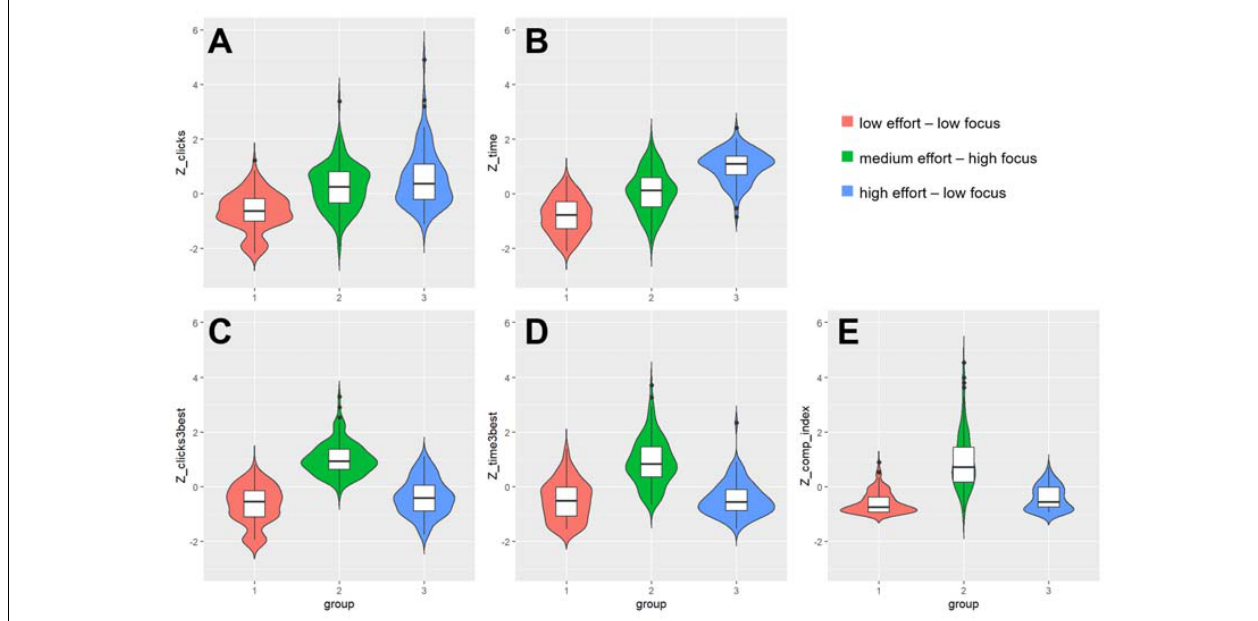
FIGURE 2 | Box and violin plots of the five behavioral measures of information processing behavior as a function of cluster assignment regarding (A) number of clicks; (B) total time; (C) clicks on 3 best; (D) time on 3 best; and (E) comparison index. Note: Boxes depict interquartile range with median in the center; density curves depict the distribution of the